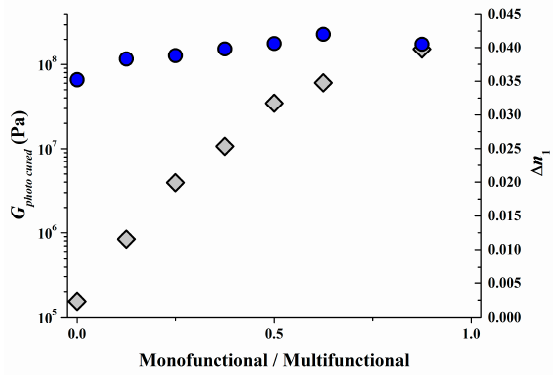
Figure 15. ∆ n 1 ( right y -axis, blue circles) and shear modulus G photo cured after flood cure ( left y -axis, grey squares) versus monomer mixing ratio (fraction of the multifunctional monomer increasing from 0 to 1).